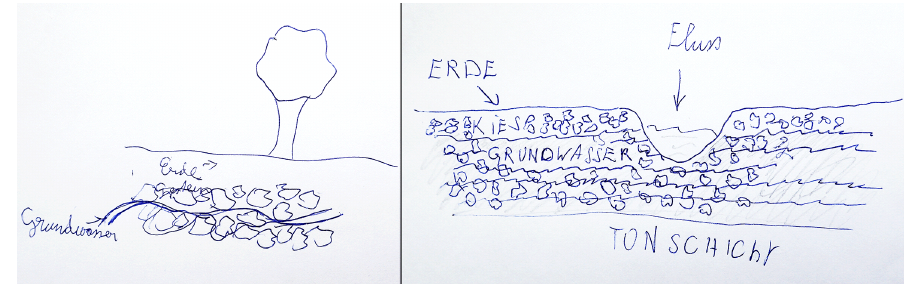
Figure 10. Example of conceptual change in a 13-year-old boy from learning with the multimedia program. Left panel: pre-test, right panel: post-test Erde (soil), Kies (gravel), Fluss (river), Tonschicht (clay layer), Grundwasser (groundwater).